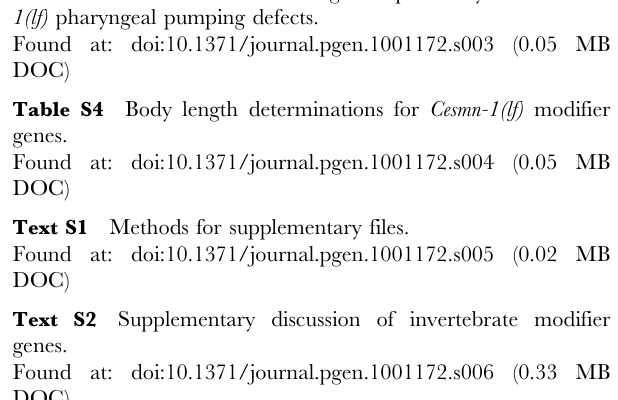
Table S3 Invertebrate modifier genes specifically affect Cesmn-